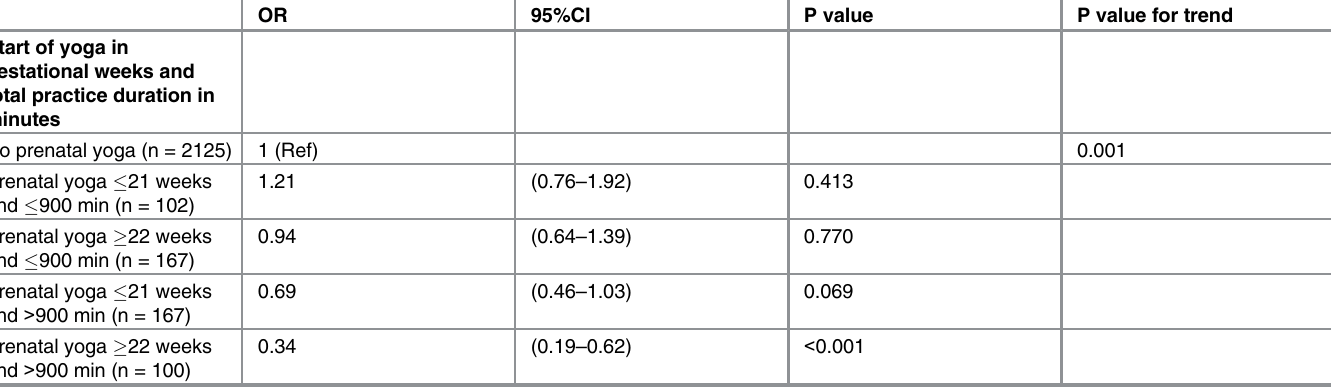
Table 4. Adjusted odd ratios for ritodrine hydrochloride use stratified by the start of yoga in gestational weeks and total practice duration in minutes.